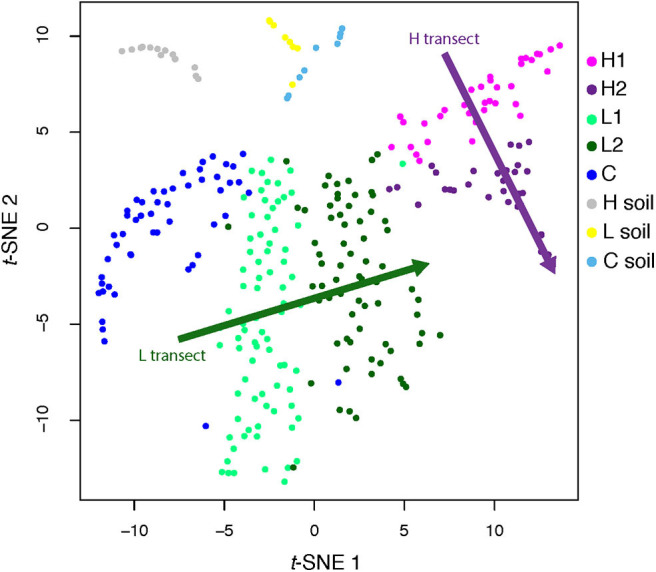
t-SNE analysis of genome abundance for each sediment sample. Each of the 300 shown genomes was assigned to the sample where it has the greatest abundance. Shaded arrows display the approximate direction of water flow, from upstream to downstream, for the high (green) and low (purple) transects. Note that these arrows do not indicate any kind of convergence.